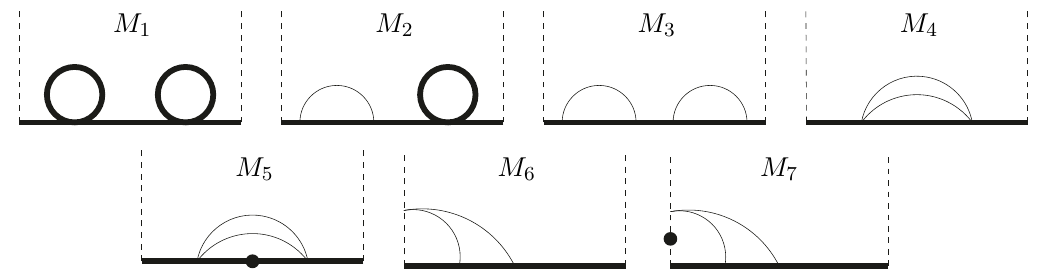
Figure 2 . The seven master integrals of family A. Bold solid lines represent massive propagators, thin solid lines represent massless propagators and dashed lines represent (lightlike) Wilson line propagators. A dot on a line means that the associated propagator is squared. Note that the o(cid:11)shell quark propagators / 1 =s are not included in the de(cid:12)nition of the master integrals M i and are only drawn here for illustration. The corresponding solutions for the I i according to eq. (5.12) are given in appendix